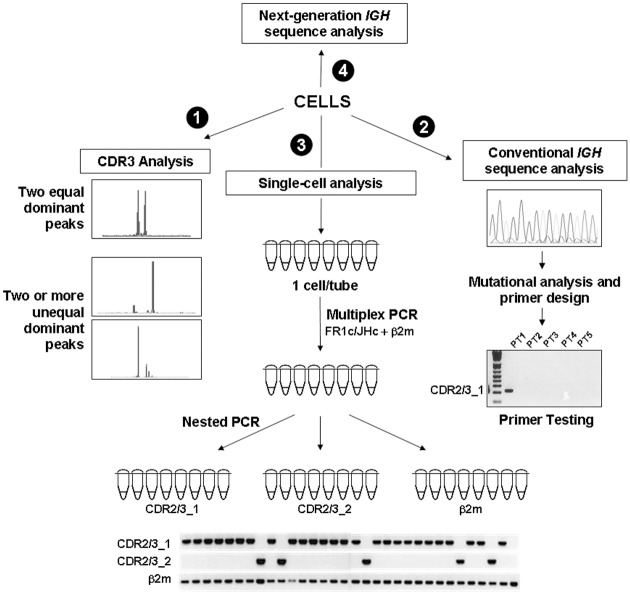
Flow chart for molecular analysis of CLL patients.(1) CDR3 analysis was initially performed to screen for patients exhibiting more than one dominant CDR3 peak. (2) Clonotypic sequences corresponding to dominant CDR3 peaks were characterized. Primers were designed based on unique sequences on the CDRs and were tested for specificity. (3) CLL cells were sorted in aliquots of 1, 10 or 100 cells and clonal analysis was performed by nested PCR using clone-specific primers. (4) Selected genomic DNA samples were subjected to next-generation IGH sequencing.